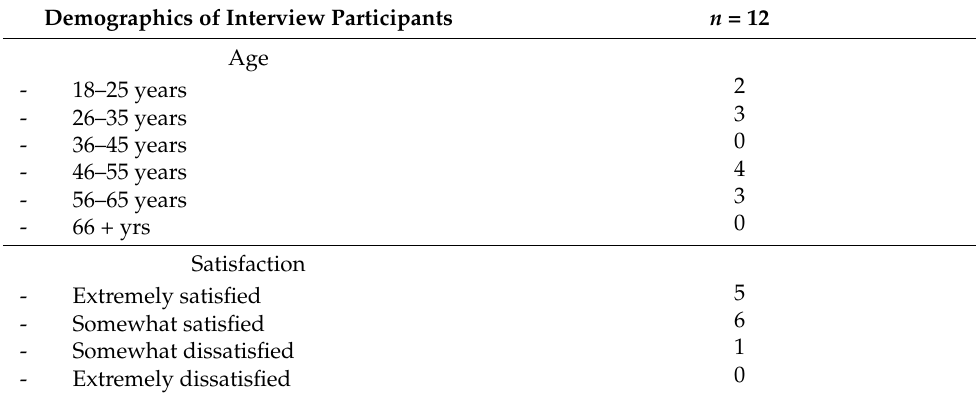
Table A3. Demographics participants in semi-structured